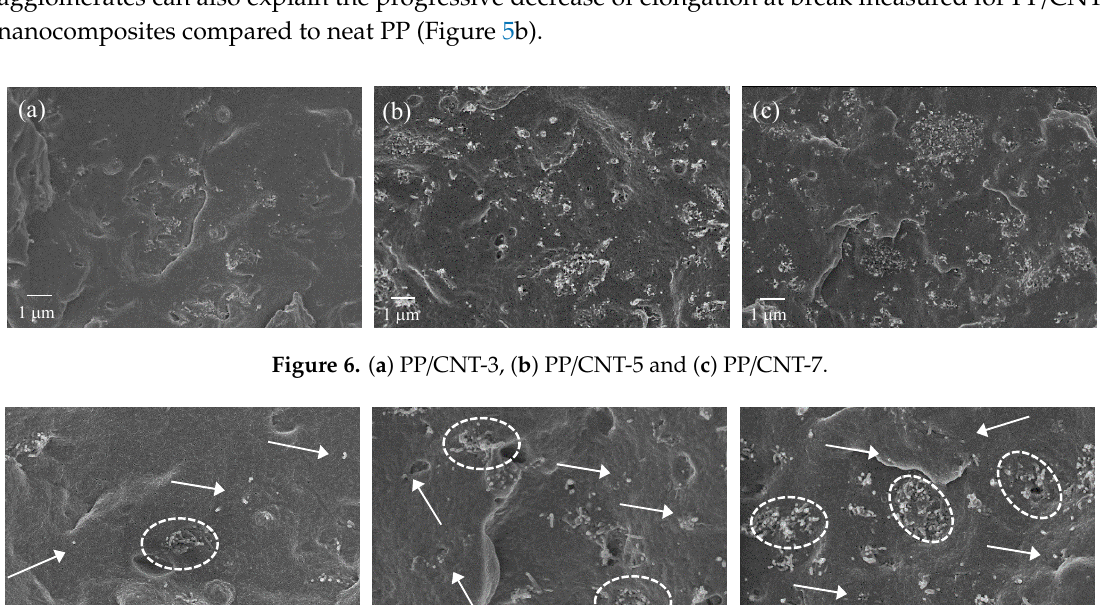
ellipsis indicate CNTs agglomerates white